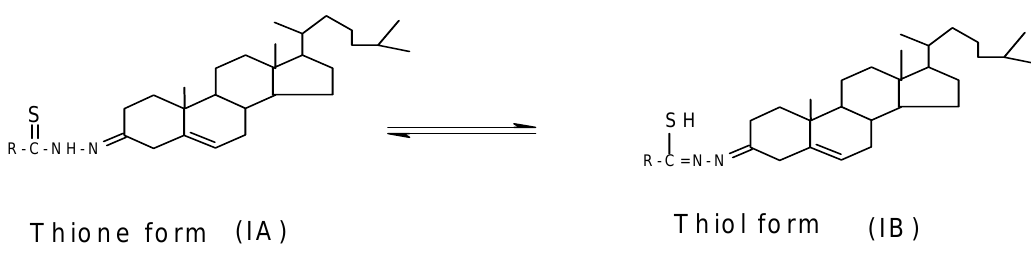
Figure 2. Structure of palladium (II) complexes: ( 1a ) R= -NHC